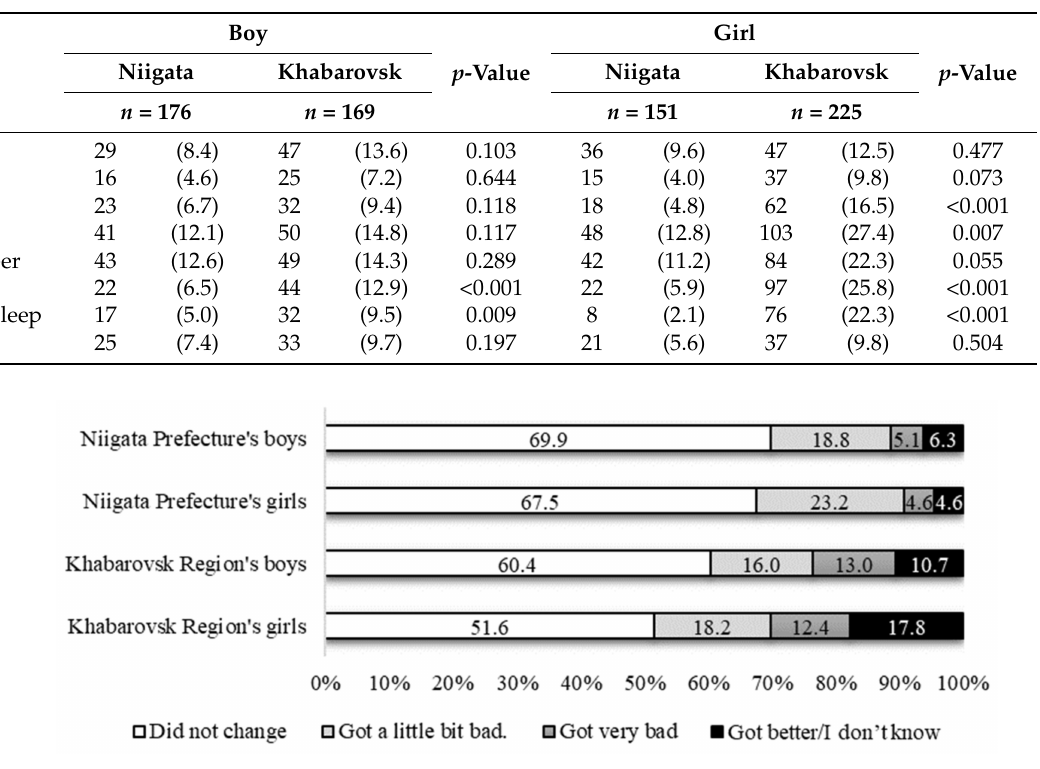
Figure 1. “Has the pandemic changed your self-assessment of health status?” ( n = 721). As for other aspects, 8.9% of the Khabarovsk boys had difficulty tolerating self-restraint (see Table 4), while a high percentage of the Niigata students were afraid of being infected with COVID-19; that is, 64.2% boys and 78.8% girls (see Table 5). Conversely, only 14.2 and 16.0% of the Khabarovsk boys and girls, respectively, were afraid of infection. To maintain good health, a high percentage of the Niigata’s adolescents practiced correct eating habits, while 77 Khabarovsk girls (34.2%) were engaged in moderate exercise. However, in Khabarovsk, 73 boys (43.2%) did not do anything (see Figure 2). The results of the binomial logistic regression showed that the factors exacerbating the self-assessment of health status differed between the boys and girls. For the Niigata boys, not having correct eating habits ( p < 0.05) and having difficulty adapting to a new lifestyle ( p < 0.05) significantly exacerbated their self-assessment of health status. In particular, not having correct eating habits resulted in an OR of 3.003 (see Table 6). For both the Khabarovsk and Niigata boys, difficulty adapting to a new lifestyle exacerbated their subjective health evaluation ( p < 0.001). Preparing to be infected with COVID-19 also had a negative impact on their subjective health evaluation ( p < 0.005) (see Table 7). Conversely, there were no factors that exacerbated the girls’ self-assessment of health status as